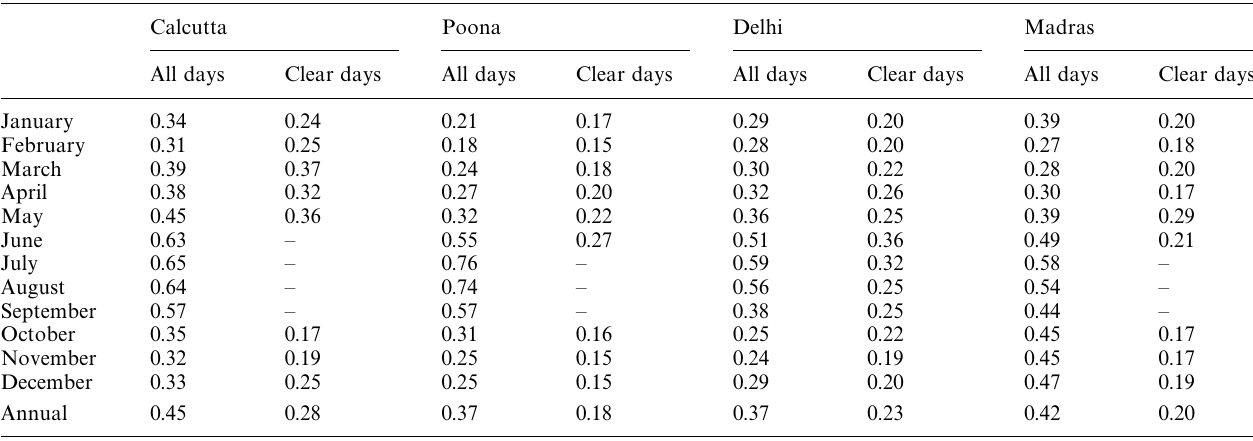
Table 5. Ratios of mean daily values of diffuse to global solar radiation for all days and for clear days only. The dashes in the table indicate that a sufficient number of clear days was not available during those months for taking a mean Calcutta Poona Delhi Madras Clear days All days Clear days All days Clear days All days Clear days